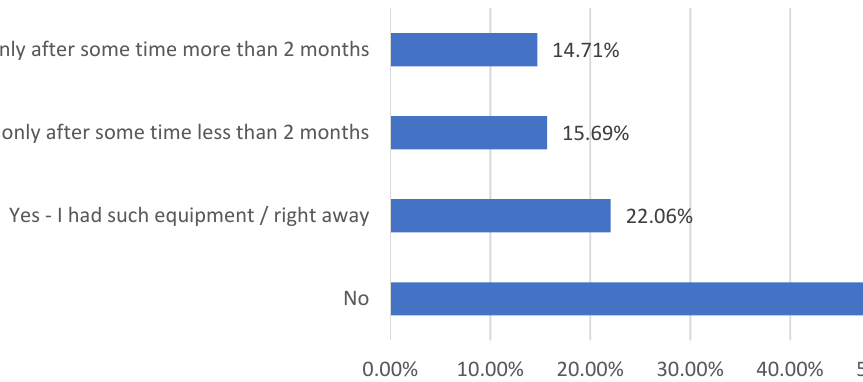
Figure 5. Due to the necessity to switch to remote work mode, have you been provided with business computer equipment?